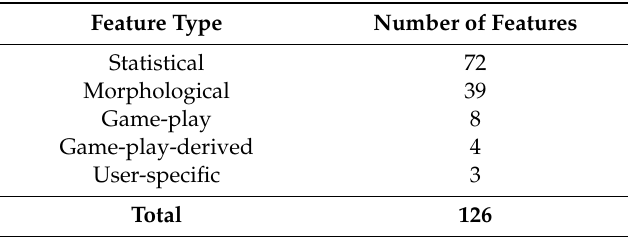
Table 4. Breakdown of feature set.